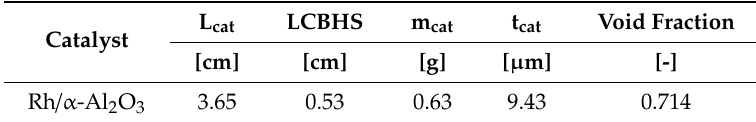
Table 3. Catalyst